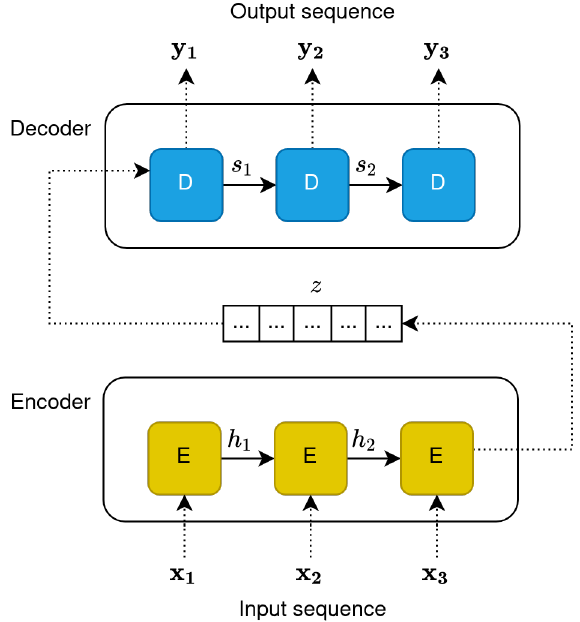
Figure 3. Unfolding of encoder–decoder architecture based on